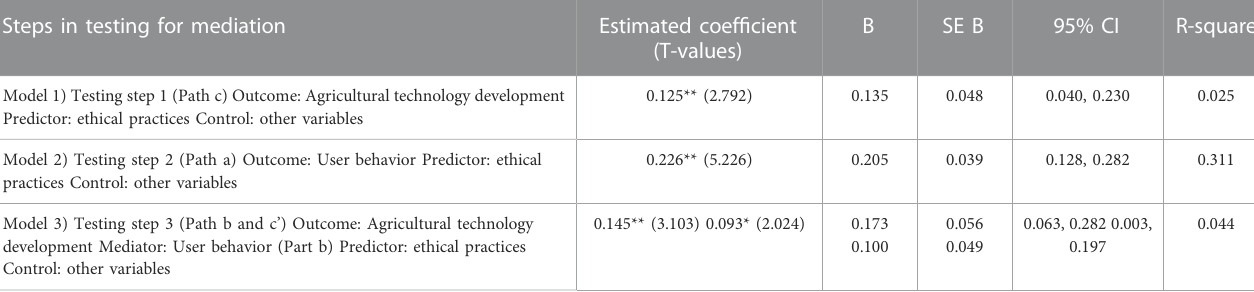
TABLE 3 Testing for User behavior as a mediator using multiple regression. Steps in testing for